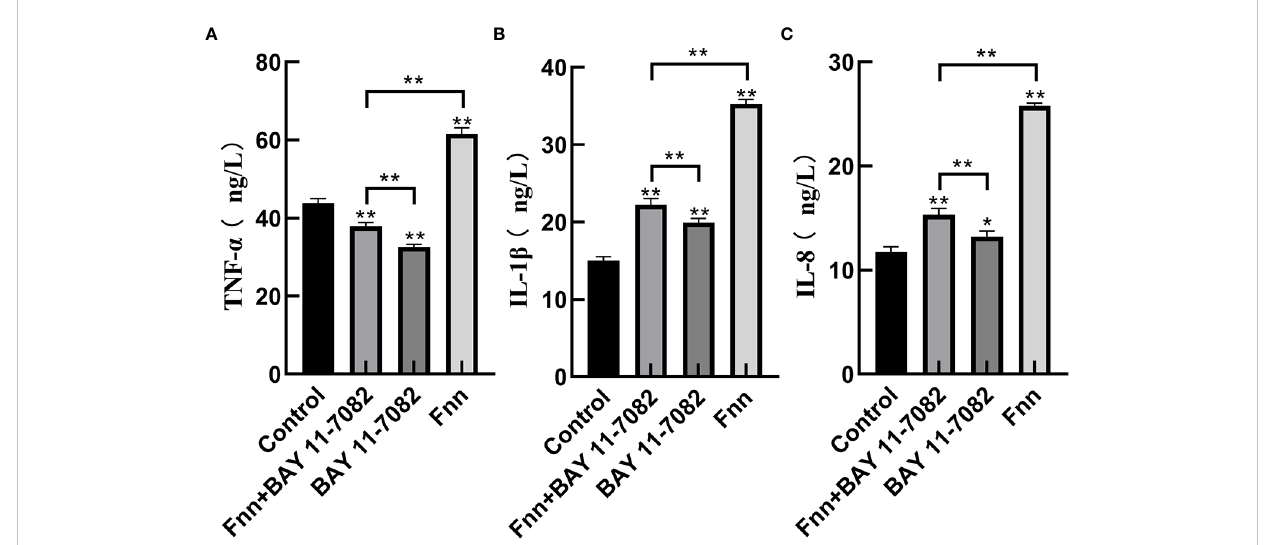
FIGURE 7 Effect of F. necrophorum infection on the concentration of proin fl ammatory cytokines in intertoe skin explants. (A – C) show the concentrations of TNF- a , IL-1 b , and IL-8, respectively. The data presented are the mean ± SD. *statistical signi fi cance (P < 0.05). **statistical signi fi cance (P < 0.01). The symbols * and ** indicate the signi fi cant differences with the control